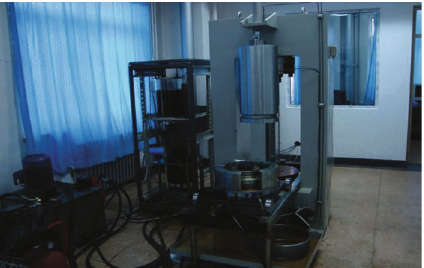
Figure 2: Rock porosity changes under compression and strain. Figure 3: The triaxial stress core rock experimental